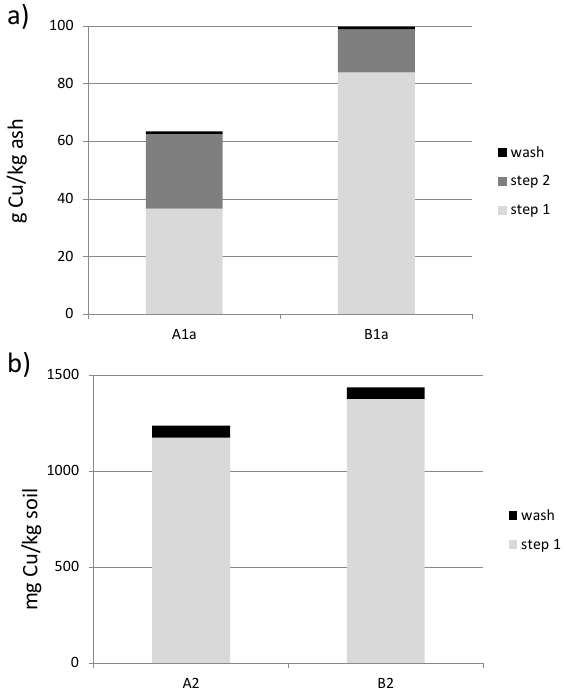
Figure 5. Amounts of Cu leached in steps 1 and 2, each 30 min, L/S = 10, followed by a washing step for ( a ) the A1a and B1a ashes; and ( b ) the A2 and B2 soils. The amounts are shown in ( a ) g Cu/kg dry ash; and ( b ) mg Cu/kg dry soil. Uncertainties in the analyses vary between 25% and